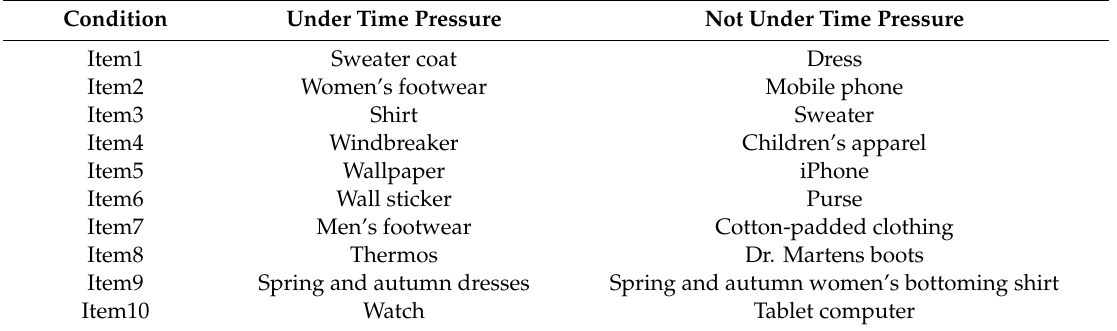
Table 1. Top 20 products on Taobao and assigned